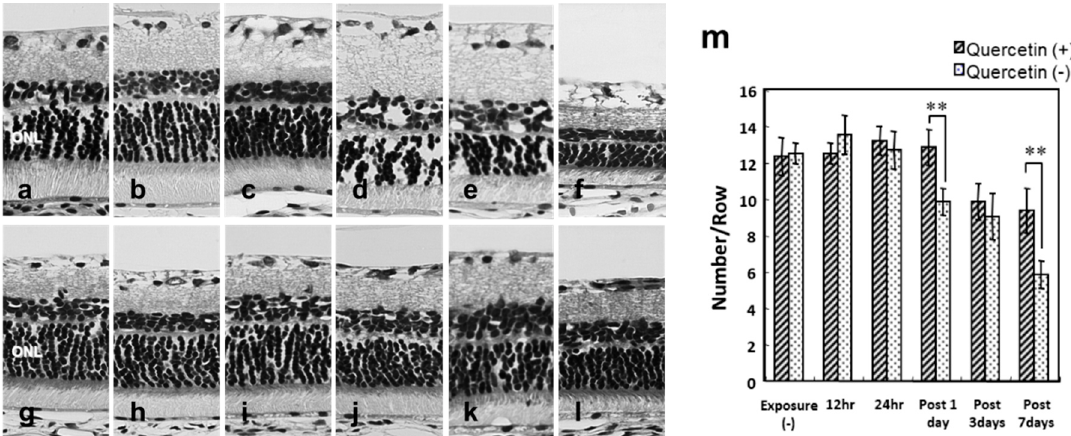
Figure 2. Light-induced retinal damage. Superior retinal samples obtained 500 μ m from the optic nerve head (ONH) are seen. ( a – f ) In the quercetin ( − ) retinas, the retinal thickness and photoreceptor cell nuclei in the outer nuclear layer (ONL) are decreased after light exposure ( a – f , m ). ( g – l , m ) In quercetin (+) retina, the decreases in thickness and nuclei are suppressed partly. ( a , g ) Unexposed retinas; ( b , h ) the retinas were exposed to light for 12 h; ( c , i ) the retinas exposed to light for 24 h; ( d , j ) 1 day after light exposure; ( e , k ) 3 days after light exposure; ( f , l ) 7 days after light exposure. Hemetoxylin & Eosin (HE) staining. Bar = 25 μ m. The data are expressed as the mean ± SD, n = 6 in each group. ** p < 0.01 by the Mann-Whitney U test. hr, hours.